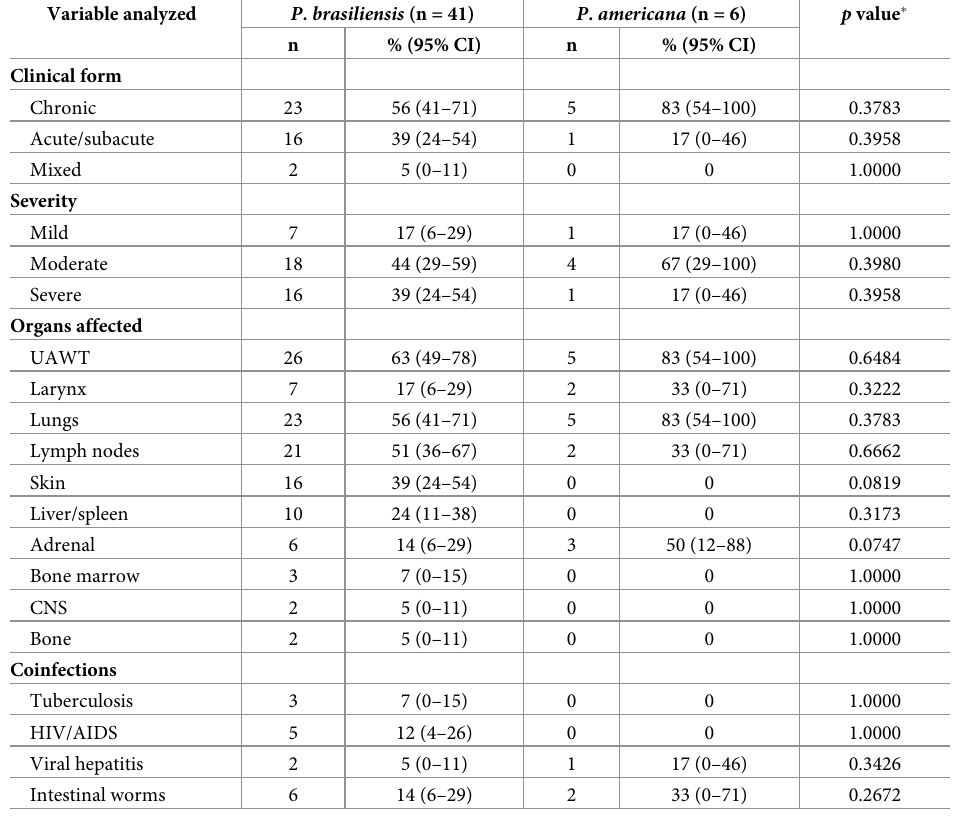
Table 2. Clinical aspects of patients with paracoccidioidomycosis according to the species identified in this study. Variable analyzed